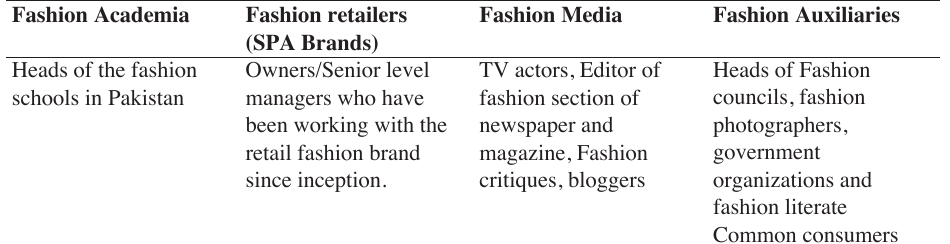
Table 1 for details of data collection clusters. Table 1: The cluster of data